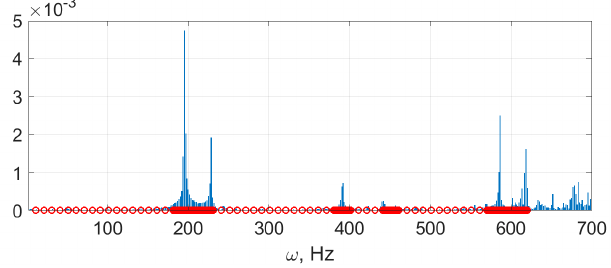
Figure 10. Mesh in the frequency domain used for massive drilling simulation.